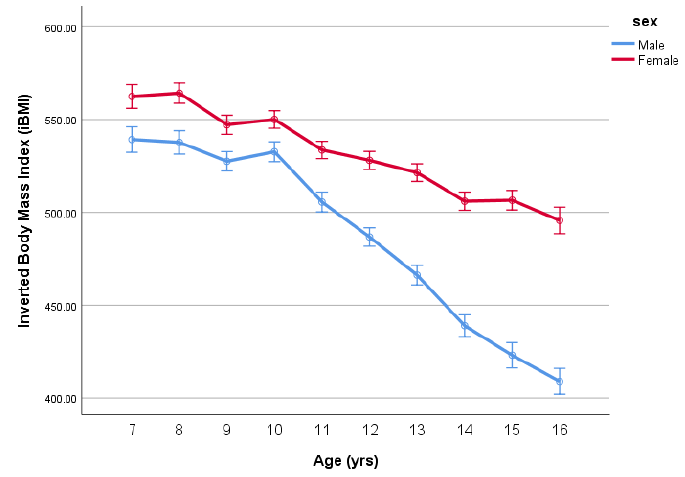
Figure 4. Inverted BMI (iBMI) (mean ± SE) by age and sex, adjusted for BF%. Table 4. The mean differences in iBMI (adjusted for BF%) by age between the boys and girls are given in Table 4 (note that the equivalent BMIs and sex differences are also reported). iBMI BMI Age Male SEE Female SEE Diff Male